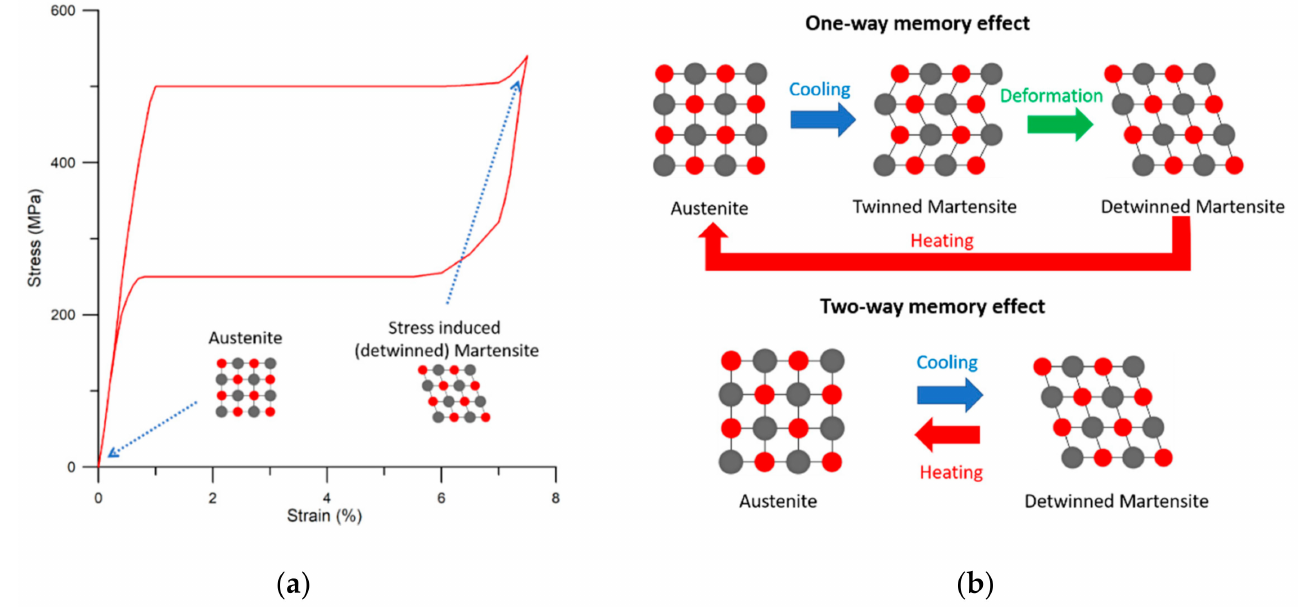
Figure 1. The fundamental properties of the NiTi SMA with their basic principles: ( a ) Superelasticity, and ( b ) One-way and two-way memory